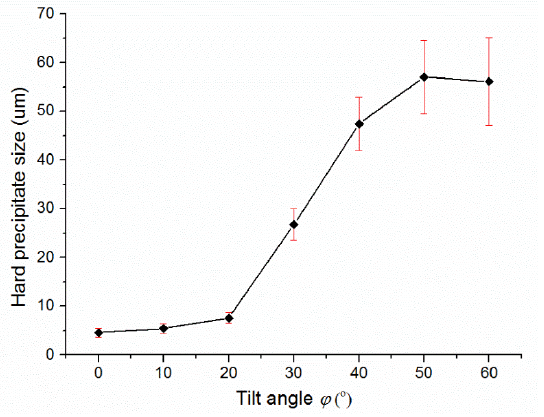
Figure 11. Influence of substrate tilt angle on hard precipitate